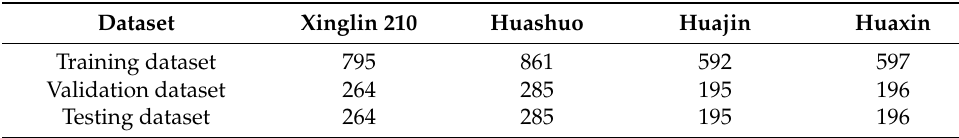
Table 1. Number of oil tea cultivar identification dataset.